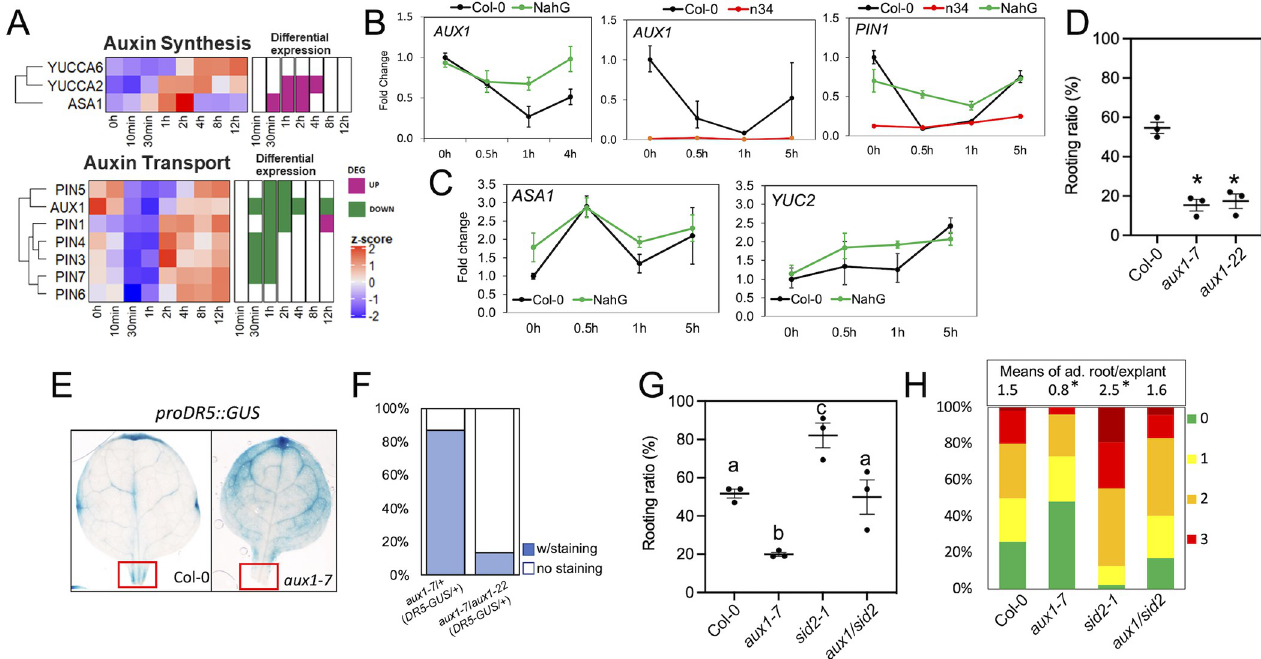
Fig 5. AUX1 acted downstream of SA to promote DNRR. (A) Expression pattern of genes involved in auxin biosynthesis and transport after leaf detaching. (B) and (C) Expression pattern of AUX1 , PIN1 (B) and YUC2 , ASA1 (C) after cutting in Col-0, npr3/4 and NahG mutant. TUB2 (AT5G62690) was used as an endogenous control in qPCR analysis. Error bars indicate standard deviation of three technical repeats. (D) Rooting ratio in loss-of-function aux1-7 and aux1- 22 . � indicates p < 0.01 when compared to Col-0 using student t -test. (E) Staining of proDR5 :: GUS in Col-0 and aux1-7 mutant. Note the lack of GUS activity in the boxed cut site in aux1-7 mutant. (F) Proportion of proDR5 :: GUS staining at the cut sites of explants from different crosses. Aux1-7 mutant carries homozygous proDR5 :: GUS . (G) Rooting ratio in aux1-7 sid2-1 double mutant. The aux1-7 mutant restored the high rooting ratio of sid2 explants to wild type levels. Different letters indicate significant difference using one-way ANOVA. (H) Average number of adventitious roots on aux1-7 sid2-1 explants. Statistics was performed by using a Mann–Whitney U